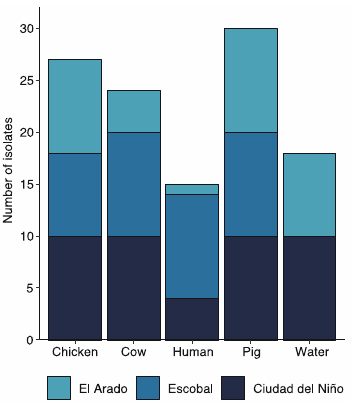
Figure 3. Tetracycline resistant strains distribution per sample source.